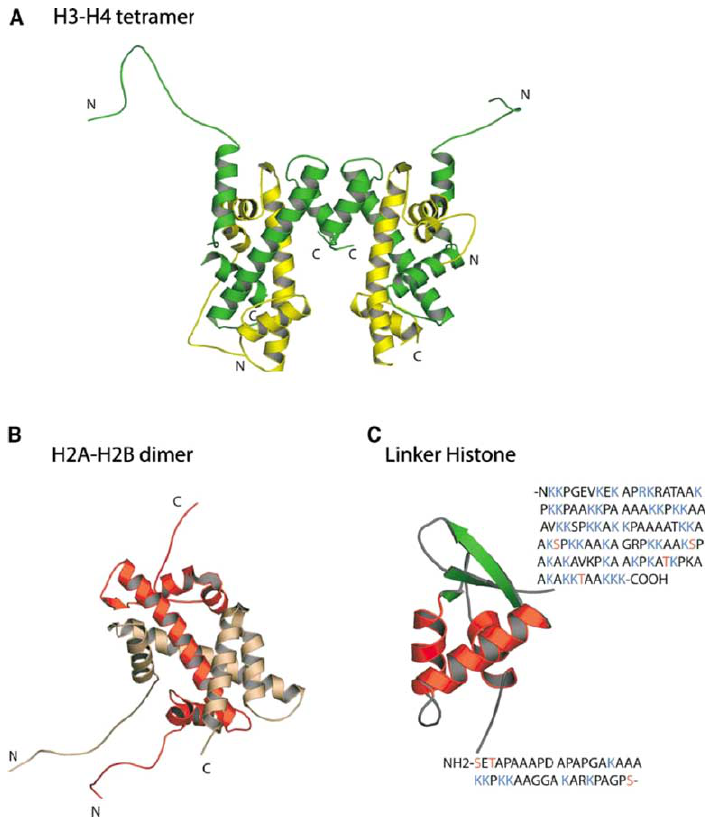
Fig. 2. Atomic structure of the core (A and B) and linker (C) histones. (a) A tetramer of H3 (green) and H4 (yellow). (b) A dimer of H2A (red) and H2B (pink). The linker histone has a conserved wing helix fold; the avian erythrocyte variant H5 is shown [166] ( Reprinted from Cell, 116, Khorasanizadeh, The Nucleosome: from genomic organization to genomic regulation, 259–272, Copyright (2004), with permission from Elsevier)